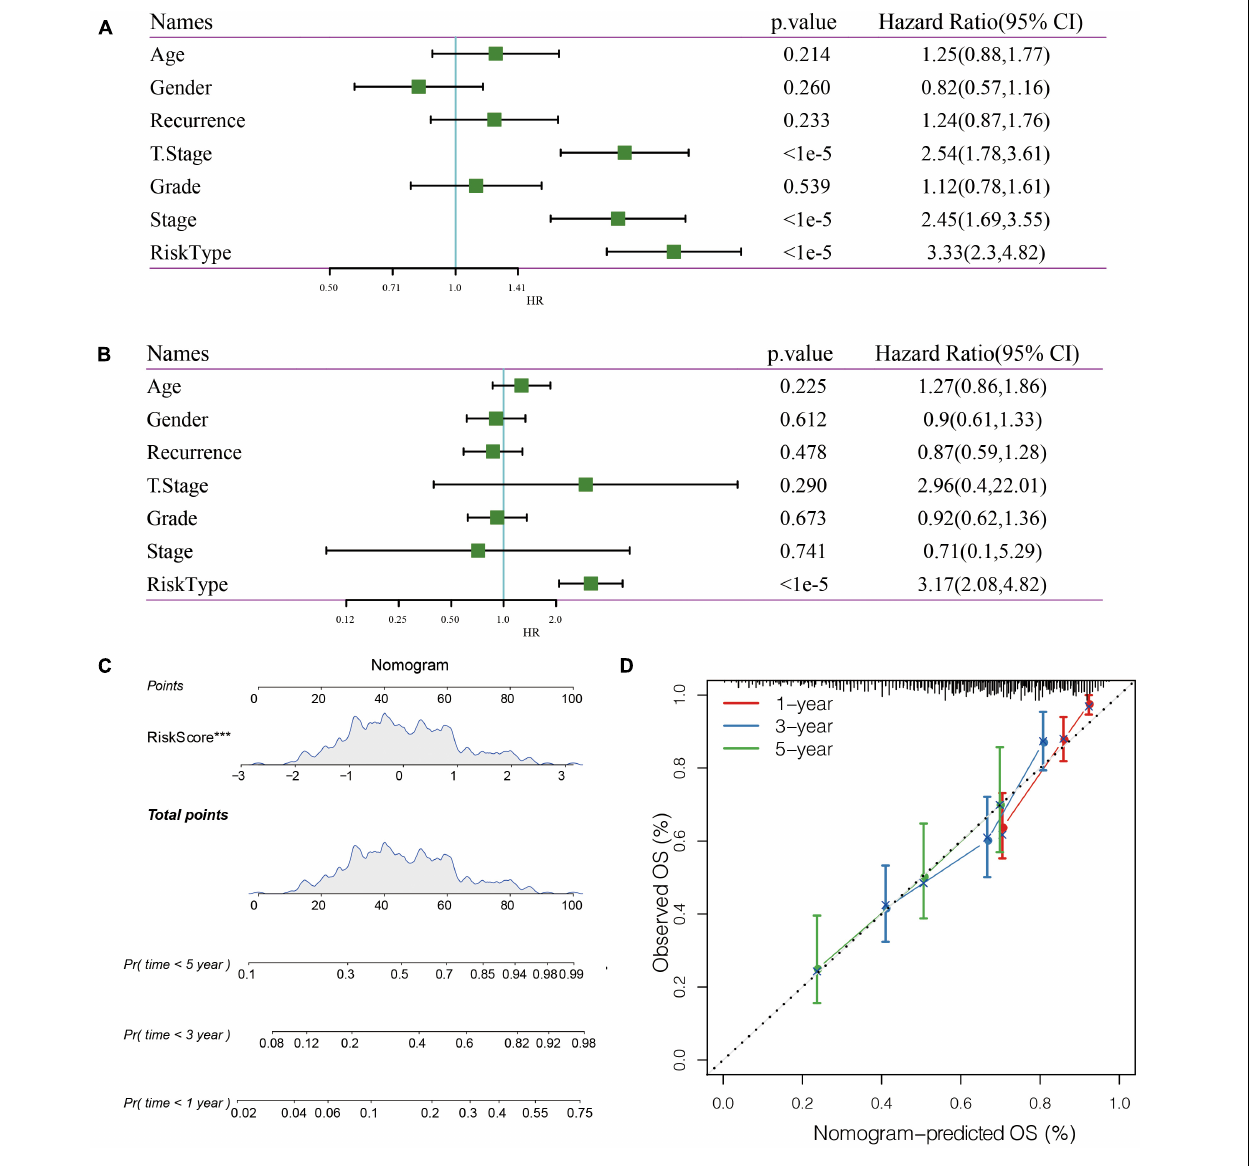
FIGURE 8 | (A) Univariate Cox analysis. (B) Multivariate Cox analysis. (C) Nomogram model. (D) : 1-, 3-, and 5- year correction curve of the